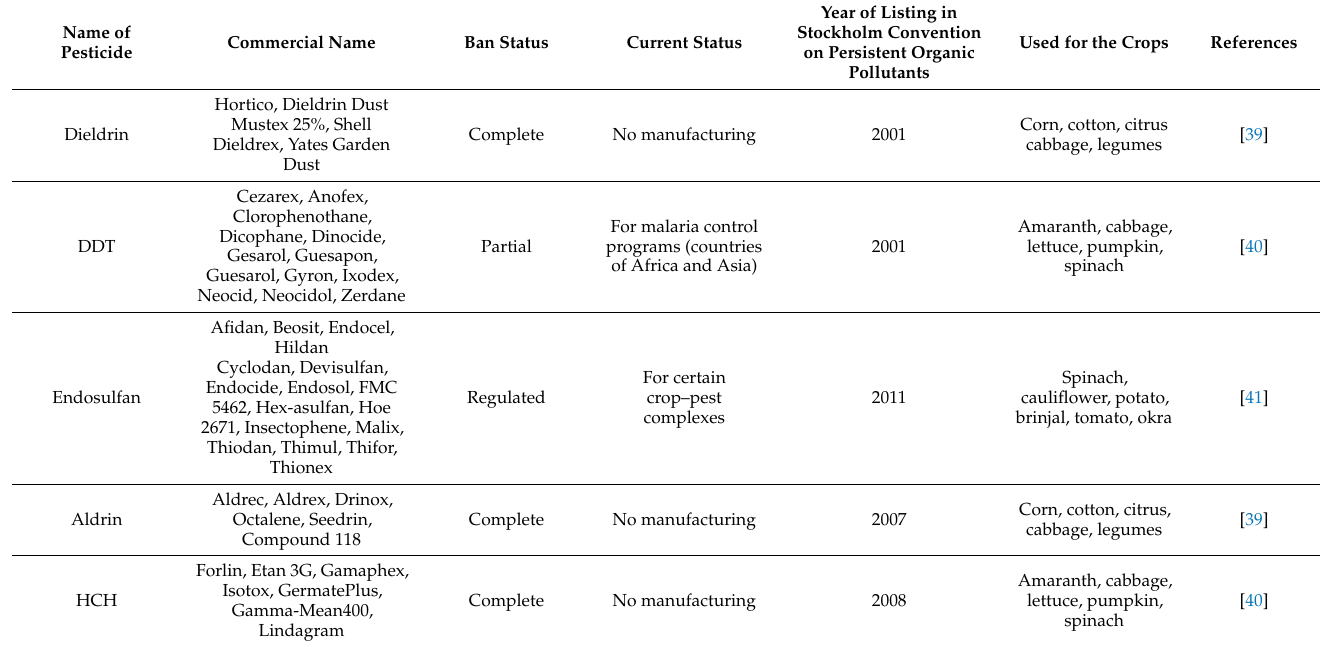
Table 1. Current use status and year listing of commercial pesticide brands around the